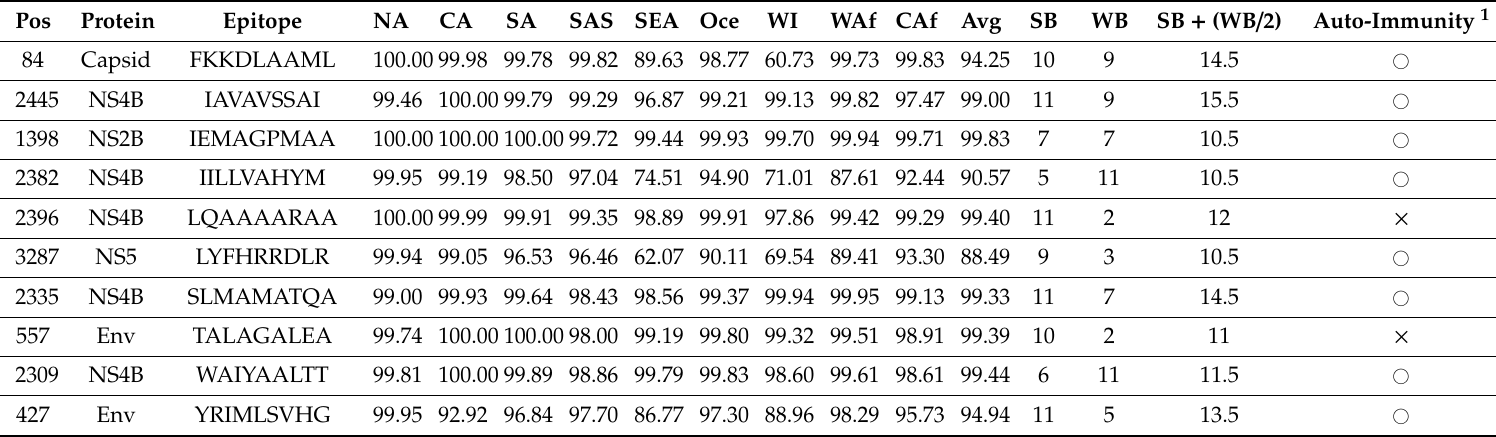
Table 3. Shortlisted ten major histocompatibility complex-II (MHC-II) epitopes, with coverage values and autoimmune induction